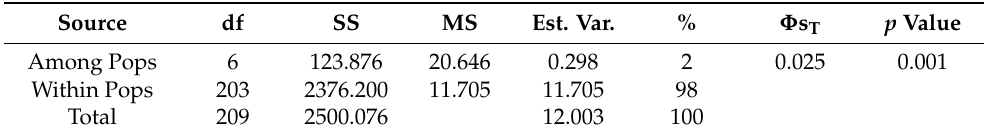
Table 5. Analysis of molecular variance (AMOVA) for 210 individuals in seven populations of pedunculate